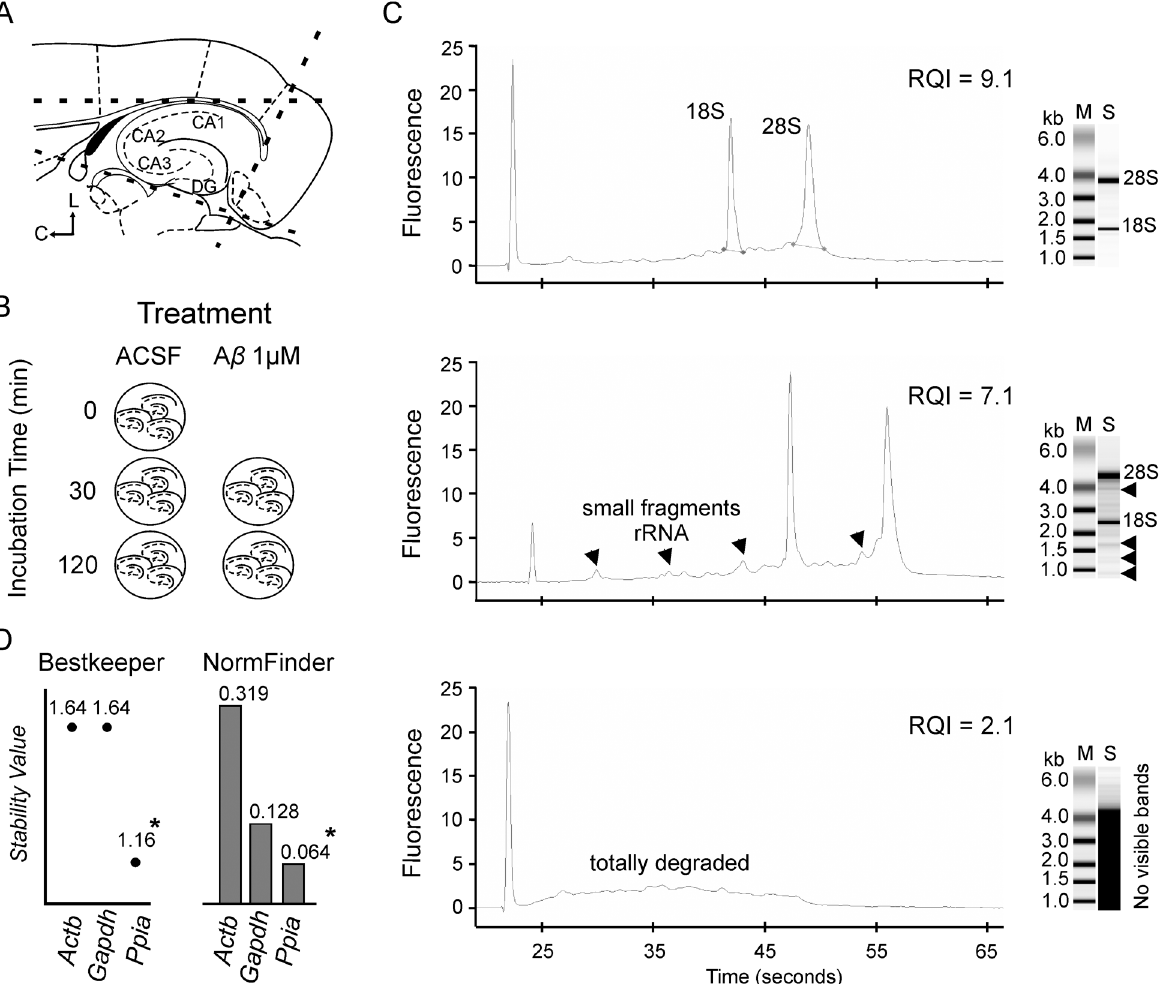
Fig 1. Experimental design, RNA integrity category examples and reference gene selection. (A) Horizontal hippocampal brain slices from one hemisphere were obtained using a dissecting microscope. Thick dashed lines indicate the cutting delimitation area. C, Caudal; L, Lateral. (B) Schematic representation of hippocampal slices incubation procedure. Slices were incubated in ACSF or A β 1° μ M during 30 or 120 min. At time zero, hippocampal slices were considered as raw tissue and mRNA level for these samples 100% since incubation effects had no begun. All experiments were performed at room temperature and bubbled with carbogen gas. (C) Representative examples of electropherogram of different RNA samples revealing RNA integrity levels and virtual images of the gels for each sample. Left column (M), molecular weight marker; Right column (S), RNA sample. RQI values are ranged from 10 (intact) to 1 (totally degraded). The gradual degradation of RNA extracted from hippocampal slices was reflected by a continuous shift towards shorter fragment sizes. The first peak found in all traces corresponds to a molecular weight marker. Electropherogram plots from top to bottom: (Top) Profile of RNA with RQI = 9.1. The peaks correspond to 18S and 28S ribosomal subunits. In this case, there are no small peaks in profile which would indicate RNA degradation. Two bands corresponding to the 28S and 18S ribosomal RNA respectively. The greater thickness of the band corresponding to 28S indicates higher concentration compared to 18S subunit. (Middle) Profile of RNA with RQI = 7.1. Arrows indicate the different peaks from degraded RNA fragments which appear at different time points along the reaction. In the sample are arrowed degraded fragments of different sizes. (Bottom) RNA profile with RQI = 2.1. Plot corresponding to highly degraded RNA can be observed. No bands can be distinguished. (D) The BestKeeper and NormFinder softwares were used to calculate the most stable gene among the 3 reference genes, in ACSF and A β incubation. For both softwares the most stable gene is that with the lowest stability value. Asterisk indicates the selected gene (Ppia) as the most stably expressed reference gene. Actb , β -actin; Gapdh , Glyceraldehyde 3-phosphate dehydrogenase, Ppia , Peptidylprolyl isomerase A.